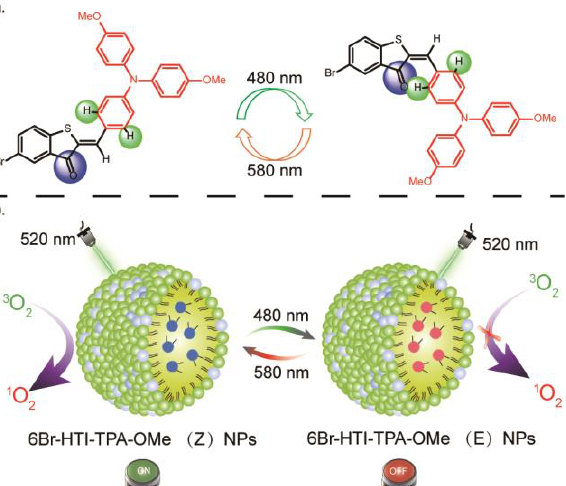
Scheme 1. The graphic illustration of a photoswitchable AIE photo-sensitizer for PDT. ( a ) The isomerization of small molecule 6Br-HTI-TPA-OMe; ( b ) schematic illustration of the controllable 1 O 2 generation in Z-NPs and E-NPs.